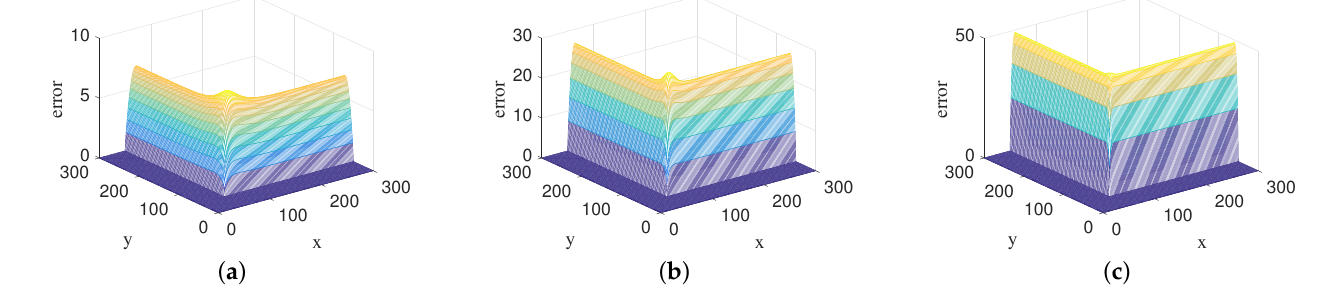
Figure 8. ( a ) denotes | kv − v | for different x , y when H x = H y = 0.3, ( b ) denotes | kv − v | for different x , y when H x = H y = 0.5 and ( c ) denotes | kv − v | for different x , y when H x = H y =